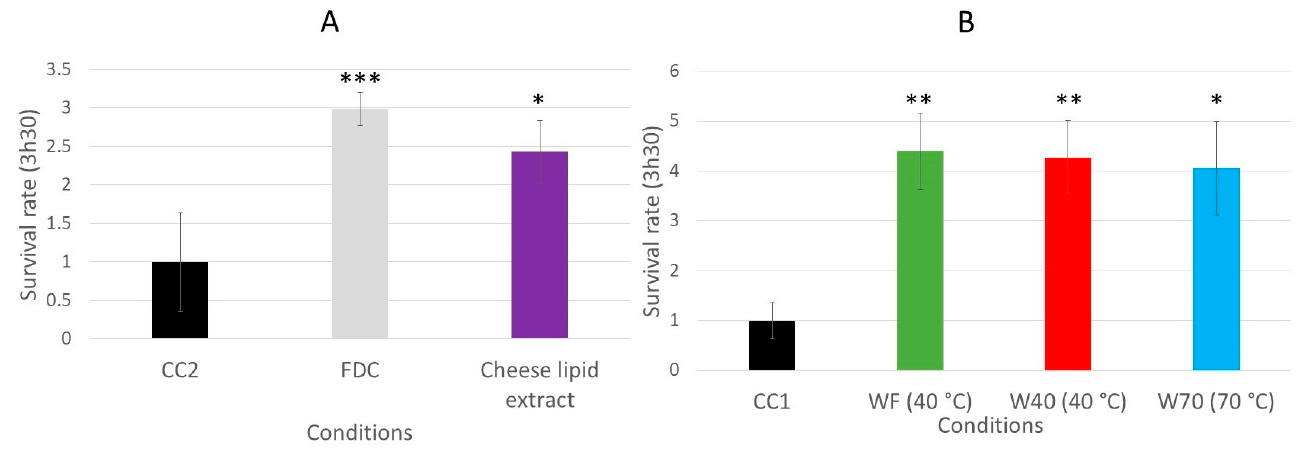
Figure 6. Relative survival rates of the wild-type C. elegans N2 strain on an oxidative medium after 5 days of incubation on a medium supplemented with FDC (freeze-dried cheese) and cheese-lipid extract ( A ) or aqueous extracts WF, W40 and W70 ( B ). The conditions were considered significantly different from the control when the p -value was lower than 0.05 (*), 0.01 (**), 0.001 (***) (Kruskal–Wallis test).